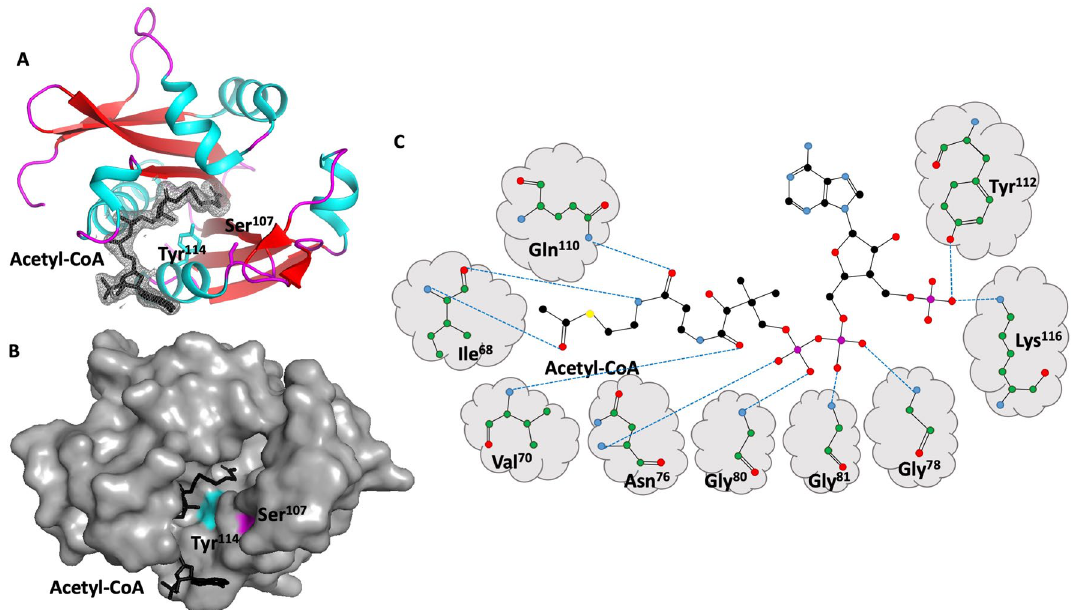
Figure 3. Acetyl-CoA binding site depicted within the tertiary structure the GNAT acetyltransferase from Elizabethkingia anophelis. Top left, shown in cartoon format, α-helices, β-strands, and loops are shown in cyan, red, and magenta, respectively. Acetyl-CoA is depicted in stick mode in black, with associated electron density map (2Fo-Fc) contoured at 1.0σ. The side chains of active site residues Tyr114 and Ser107 are depicted in stick mode. Bottom left, the same structure as above, but shown in surface view and coloured grey to depict the binding cleft. The location of Tyr114 and Ser107 are coloured cyan and magenta respectively. Right panel, schematic of hydrogen bond interactions between GNAT acetyltransferase residues and